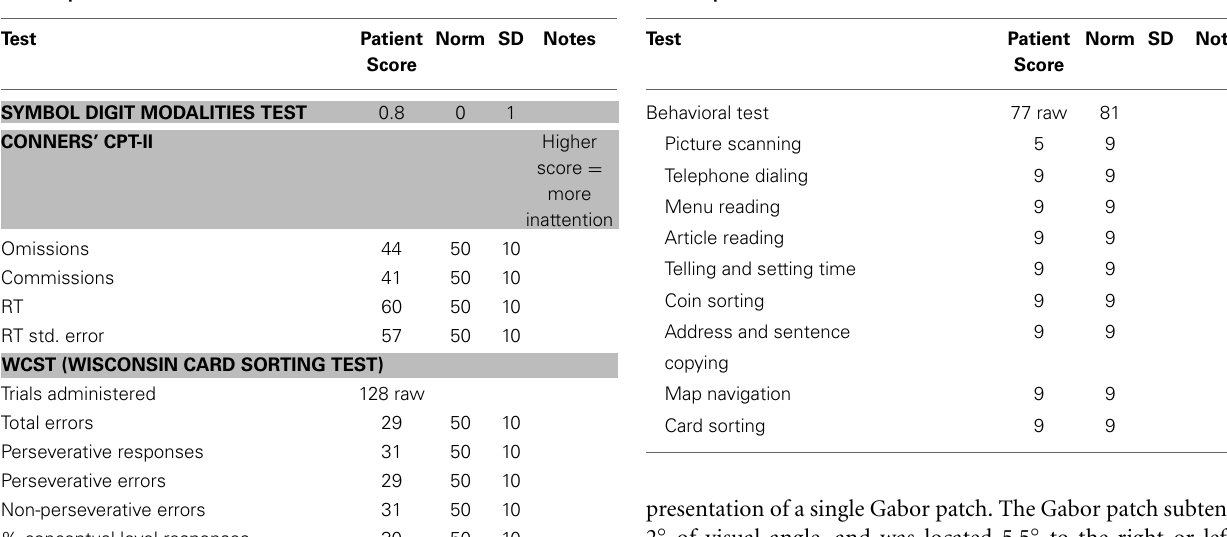
presentation of a single Gabor patch. The Gabor patch subtended 2 ◦ of visual angle, and was located 5.5 ◦ to the right or left of central fixation. Each Gabor patch was oriented either 45 ◦ or 135 ◦ from the vertical. The subject’s task was to indicate with a button press whether the Gabor patch was rotated clockwise or counterclockwise relative to vertical. A color change of the cen- tral fixation spot signified the start of the response period, during which the participants pressed a button to indicate the orienta- tion of the Gabor patch. During the threshold measurements, no attentional cues were presented at any location. The contrast of the Gabor patch was reduced 1% after a subject responded cor- rectly three times in a row and was increased 1% when a subject responded incorrectly once, thus yielding an overall approximate accuracy of 75%. This threshold procedure was conducted sepa- rately for Gabor patch locations to the left and right of fixation. The larger of the two contrast threshold values (for left and right stimulus locations) was used for the attention experiment that followed.